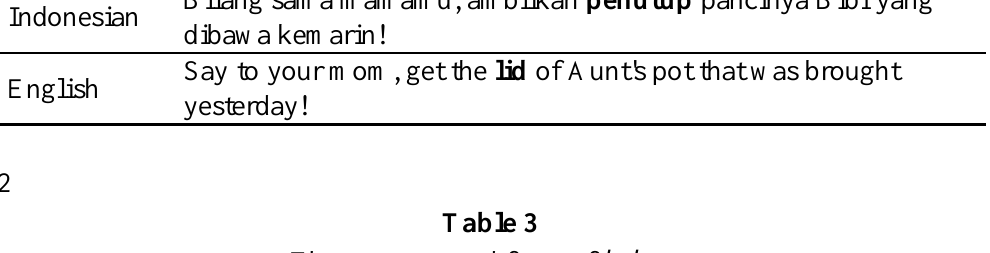
The correct word form of kabesar